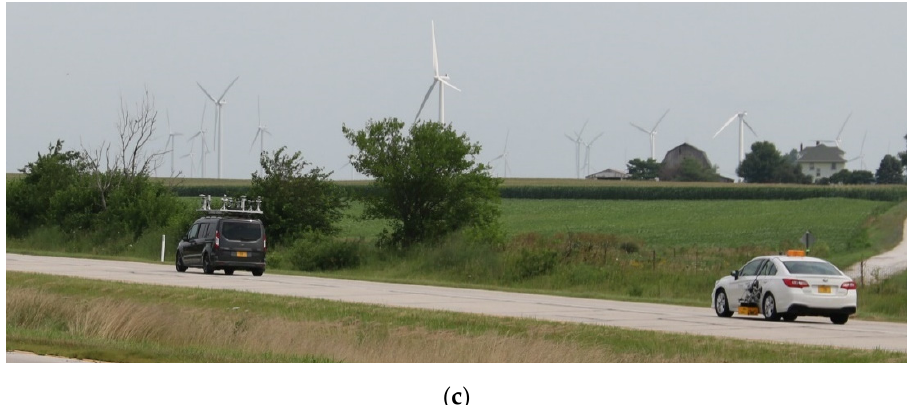
Figure 1. Data collection route and equipment: ( a ) Indiana US-52 westbound and US-41 northbound evaluation; ( b ) Indi- ana US-52 westbound and US-41 northbound evaluation concentrated on evaluation area; ( c ) data collection convoy and equipment.